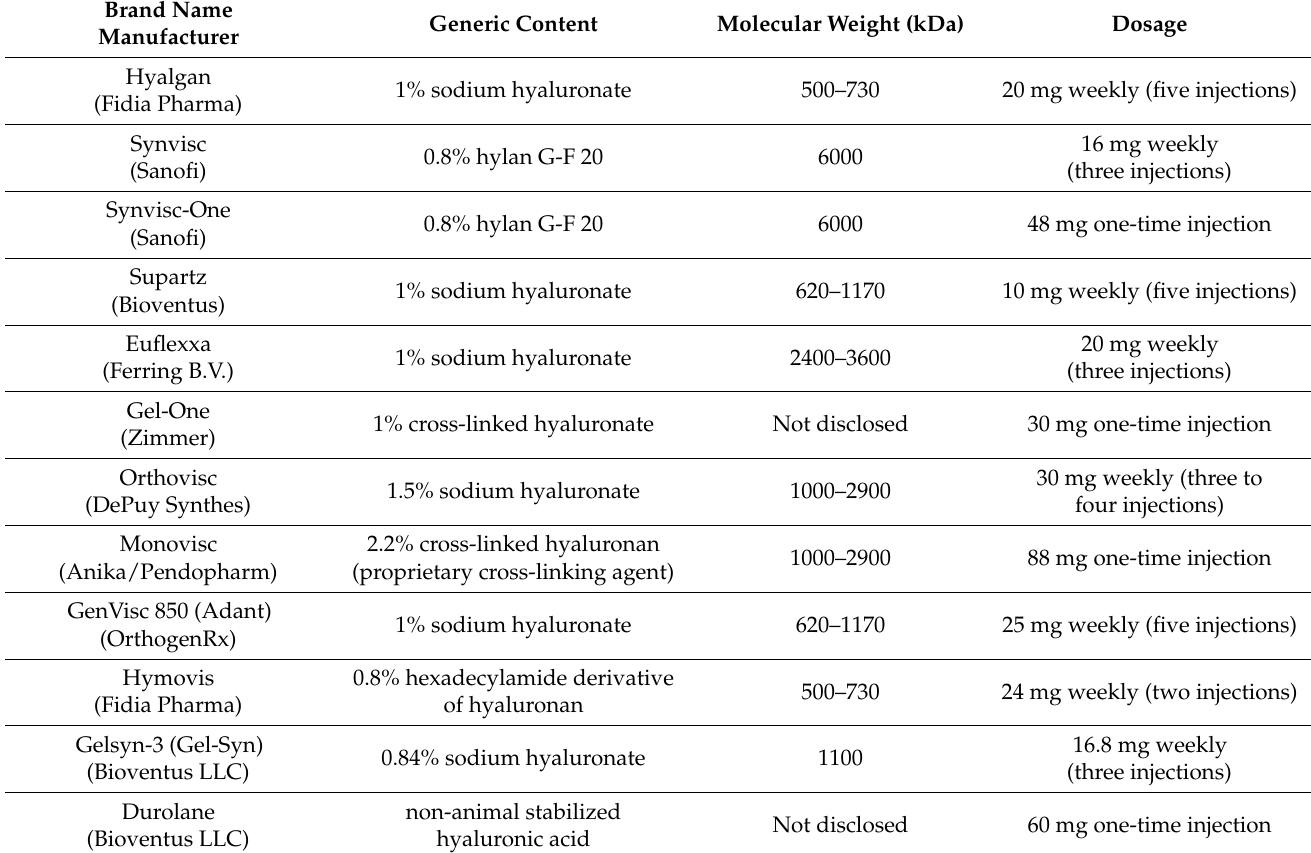
Table 2. Varieties in the molecular weight and dosage of hyaluronic acid